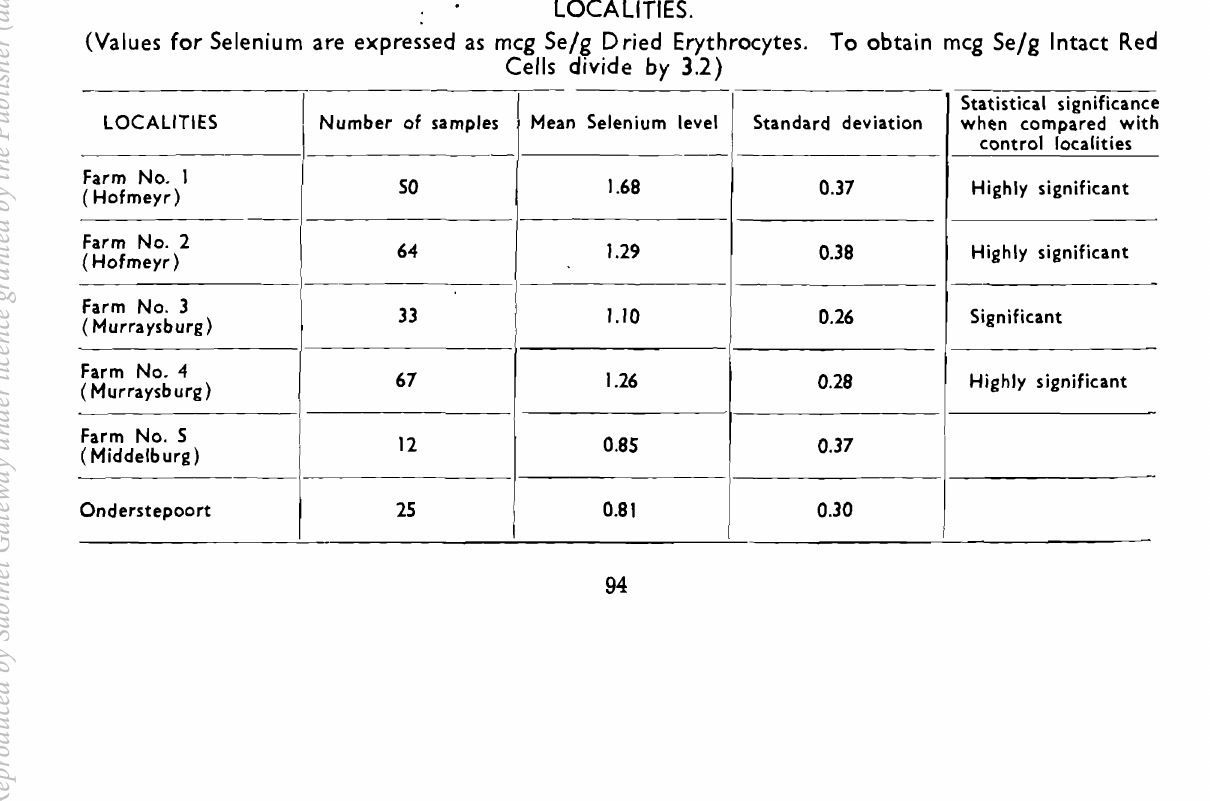
Table I.-SELENIUM LEVELS IN THE ERYTHROCYTES OF SHEEP FROM DIFFERENT